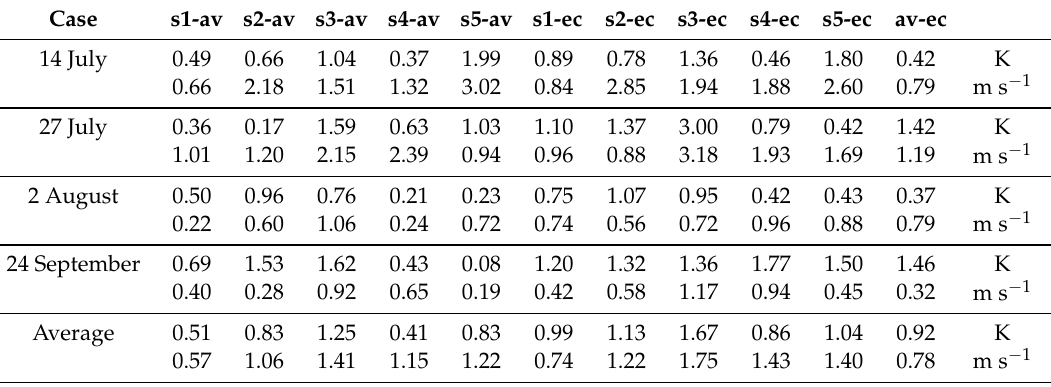
Table 2. Root mean squared error (RMSE) of each site in respect to the average of sites (five left columns), RMSE of each site and of the average in respect the European Centre for Medium-Range Weather Forecasts (ECMWF) model profile (next five columns) . The RMSE value of the virtual potential temperature is the upper value of each cell (in K), and the lower one is the wind speed (in m s − 1 . The last numerical column displays the RMSE between the average of sites and the ECMWF